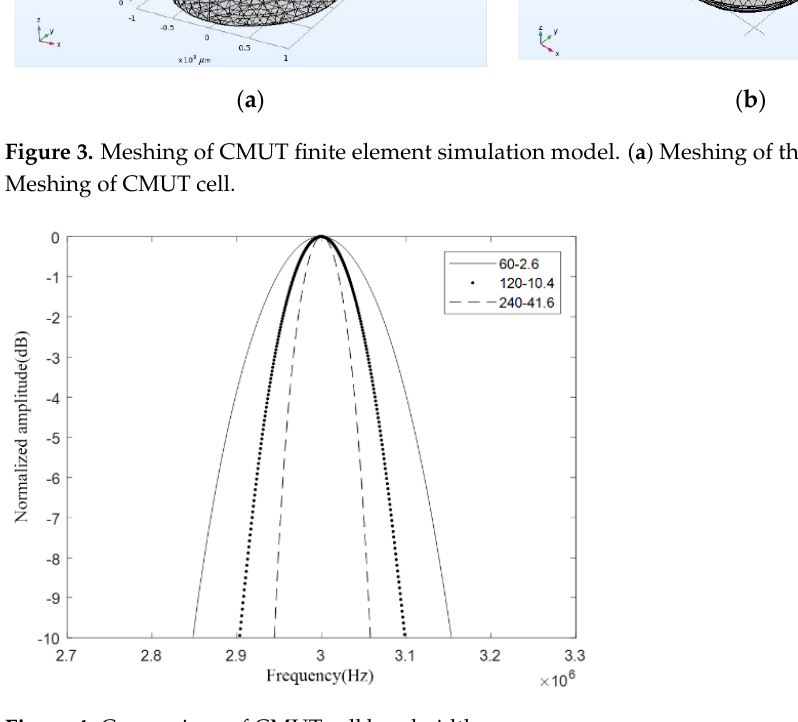
Figure 4. Comparison of CMUT cell bandwidth.